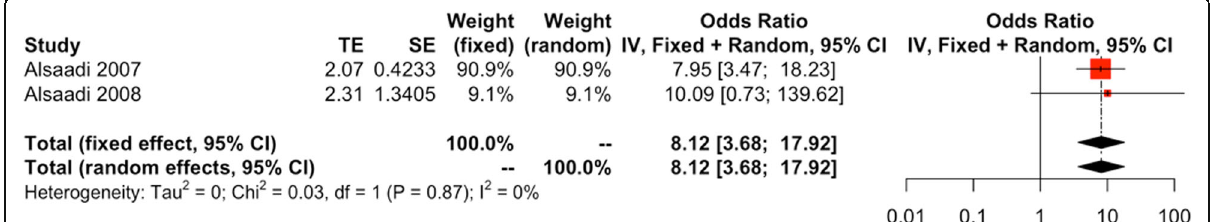
Fig. 2 Meta-analysis of two studies investigating the effect of Crohn ’ s disease on early implant